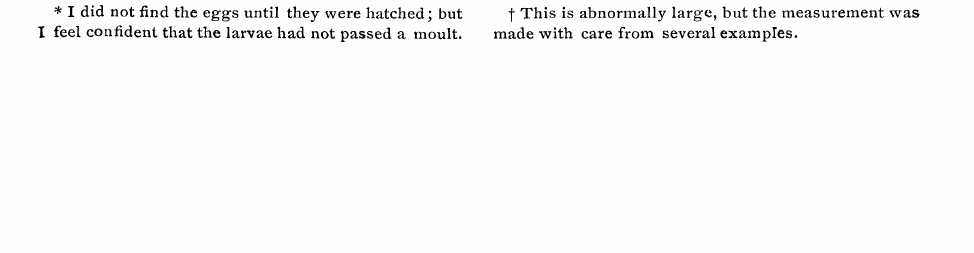
black, joint 2 bluish with a large subdorsal wart; large black spots on joints 3 and 4. A dorsal blue line, broken into a series of nearly connecting segmentary spots, enlarged on the anterior part of the segment and tapering behind, present only on joints 3-12. Joint 13 bluish. A.t orange subdorsal line; a blue band below it; a yellowish lateral line; a narrower blue band a substigmatal yellow- ish line, each of these narrowly separated by the black ground color; a yellowish line along the bases of the legs. Abdominal feet black, testaceous at tip. Venter black. fi’o,trl/a stag’e.Head bluish with small black spots,labrum white, jaws black width 1.4 ram. Body flattened below, feet spreading, joint 12 a little enlarged dorsally. A row of white dorsal spots, one on each segment on joints 3-11 but nearly broken into two, a large spot narrowly connected with a little one behind it. The orange subdorsal line is supple- mented by a few orange dashes in the dorsal space; lateral and substigmatal lines orange but paler, the blue filling in nearly the whole space between them, except for the spots on Cervical joints 3, 4 and 2, and a row of much smaller ones on the intervening joints. The broken , line along the bases of the legs is pale orange. Joints 2 posteriorly and 13 are blue gray. [[air all reddish, thin on the back, but quite thick subventrally. Feet black, the abdomi- nal paler at the tips. Fift/ stage. Very much as before; width of head 2.i mm. The anterior one of the two white dorsal spots on each joint of joints 3-2 is pointed behind and followed by the posterior small rounded spot. On joints 3, 4and 2 the blue band is broken bya quad- rate black spot as in the previous stage and on joints S- and 3, there is a small black spot, defined as an incision in lower edge of band. This is abnormally large, but the measurement vas made with from several